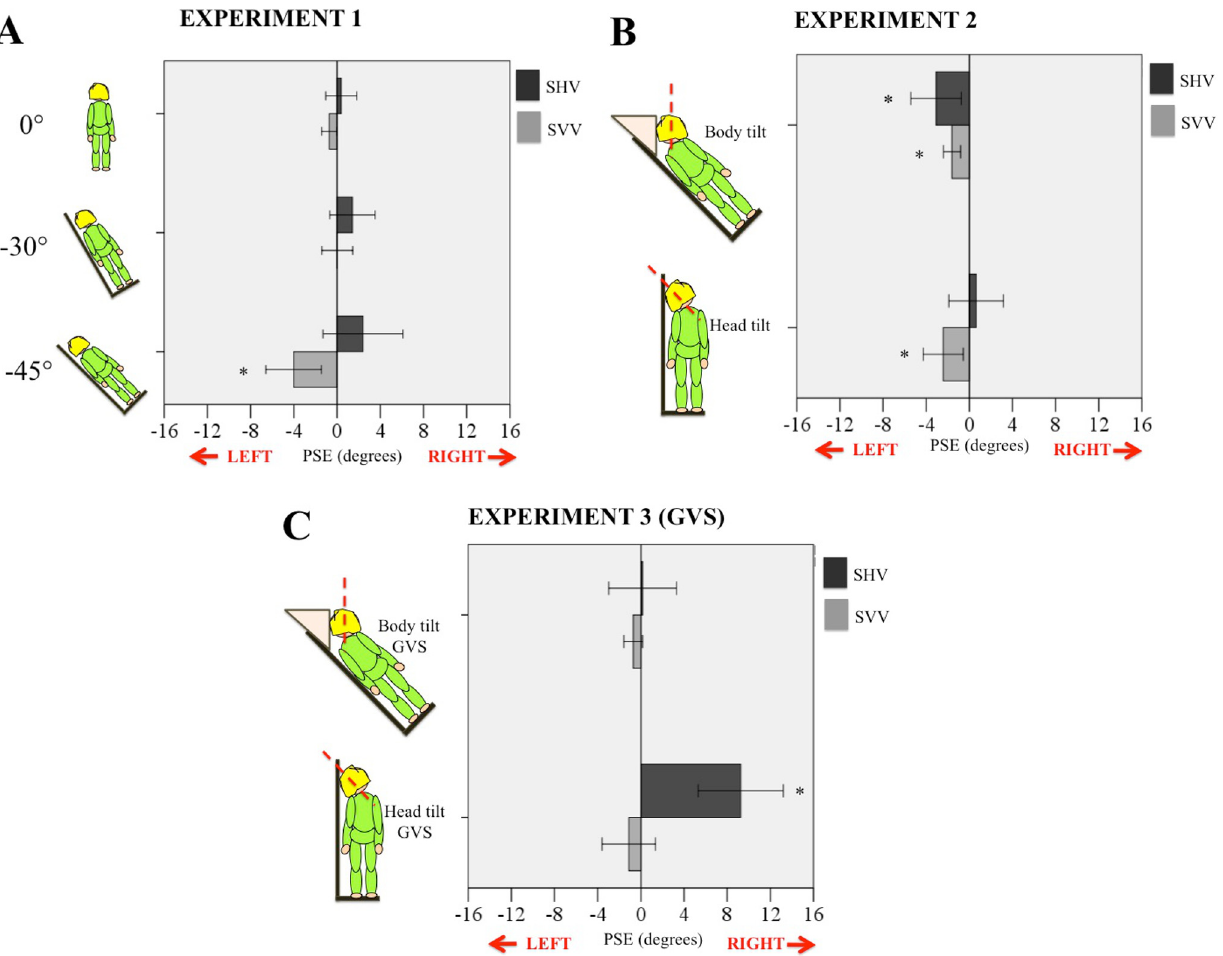
Fig 2. Results for experiments 1 – 3. A. Experiment 1. Mean PSEs for SHV (black) and SVV (grey) for each of three body tilts (0°, 30° and 45°, shown as insets on the left of histogram) where 0° corresponds to gravitational vertical. B. Experiment 2. Mean PSEs for SHV and SVV for head and body tilt (see insets on the left). C. Experiment 3. Mean PSEs for SHV and SVV for head and body tilt with disruptive GVS. Asterisks indicate mean was significantly different from 0° at p < 0.05. Error bars are 95% confidence intervals, which make clear which conditions included an accurate perception of gravitational